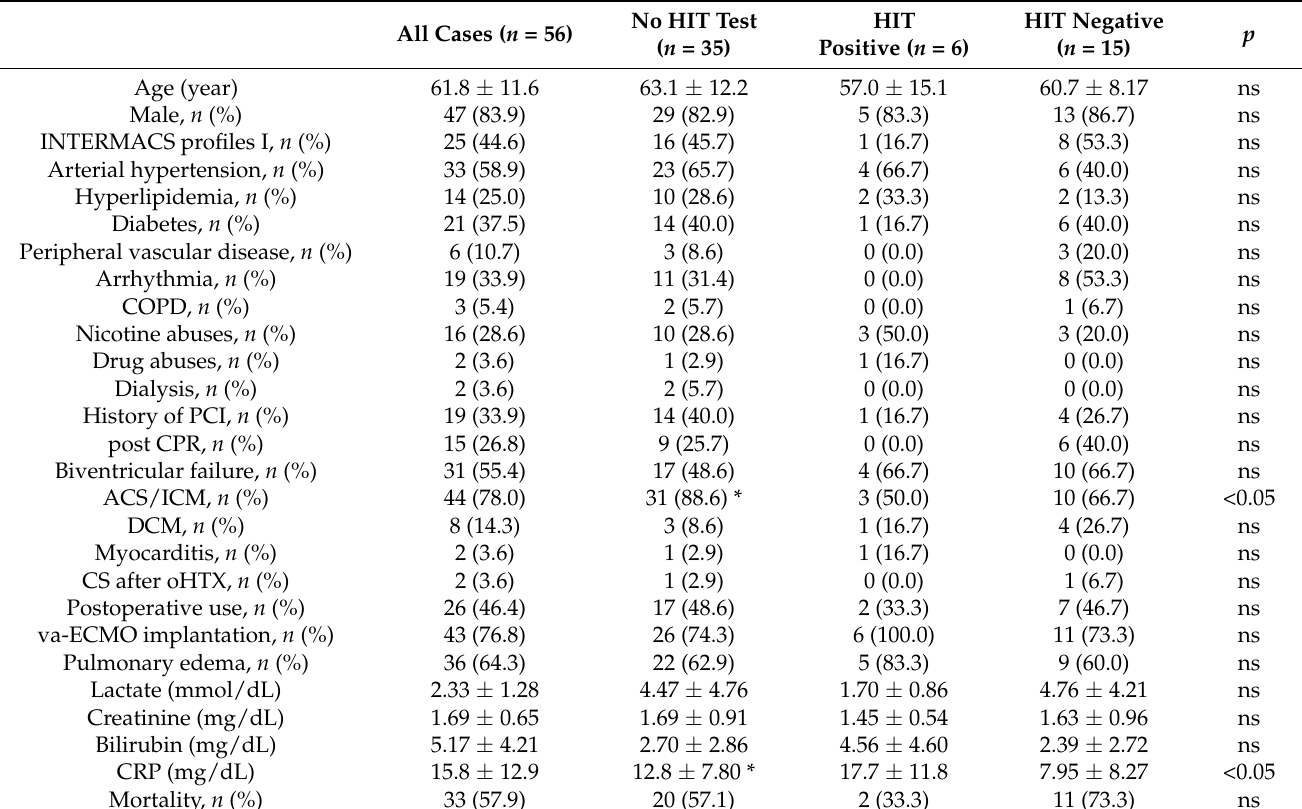
Table 1. Baseline clinical characteristics and